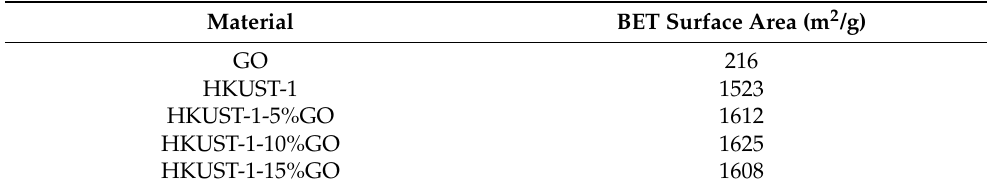
Table 1. BET results of GO, HKUST-1, HKUST-1 with 5%GO, HKUST-1 with 10% GO, HKUST-1 with